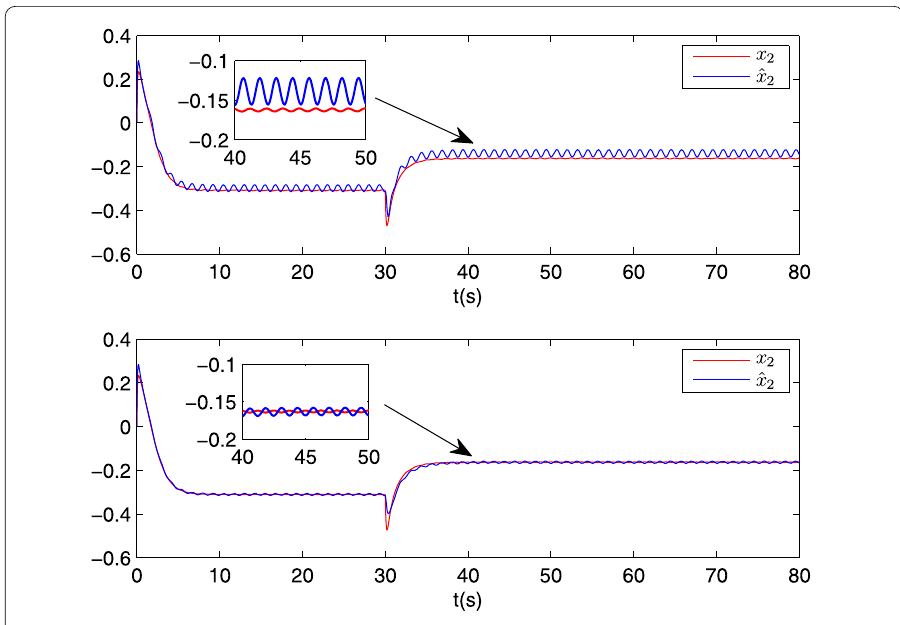
Figure 2 State x 2 ( t ) and its estimation. The blue line denotes state x 2 ( t ) while the red line denotes its estimation. The lower part is the result obtained using method proposed in this paper, while the upper part is the result obtained using method proposed in [11]